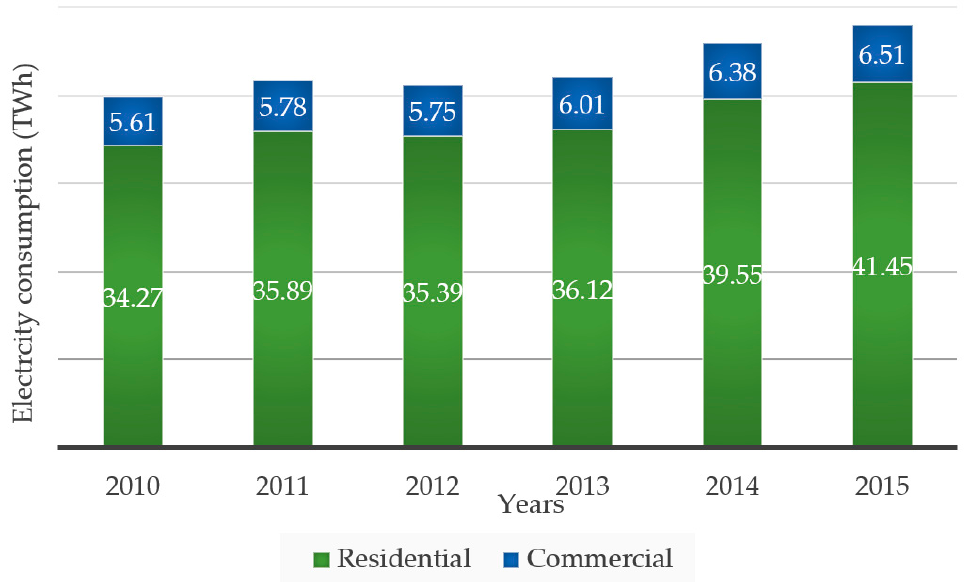
Figure 15. Building electricity consumption in Pakistan , showing increasing electricity consumption over the years [12].